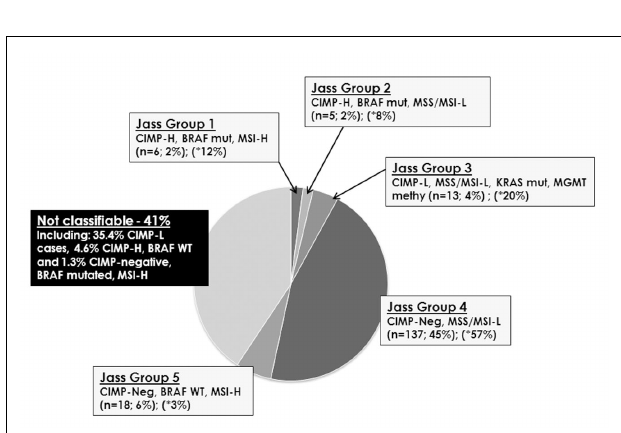
FIGURE 1 | Method of calculation used for determining methylation status. The pyrograms show percent methylation at five CpG sites in a colorectal cancer and its corresponding normal mucosa; the individual CpG scores are averaged for each.The mean percent methylation from the